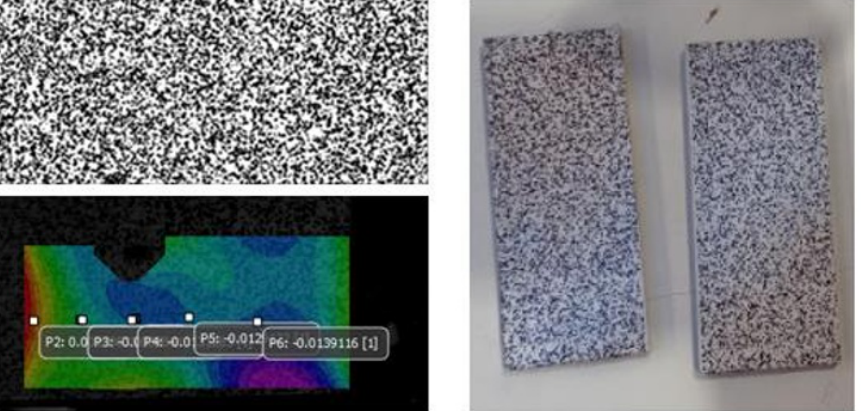
Fig. 2. DIC pattern using water-slide paper technique and the PMMA strain